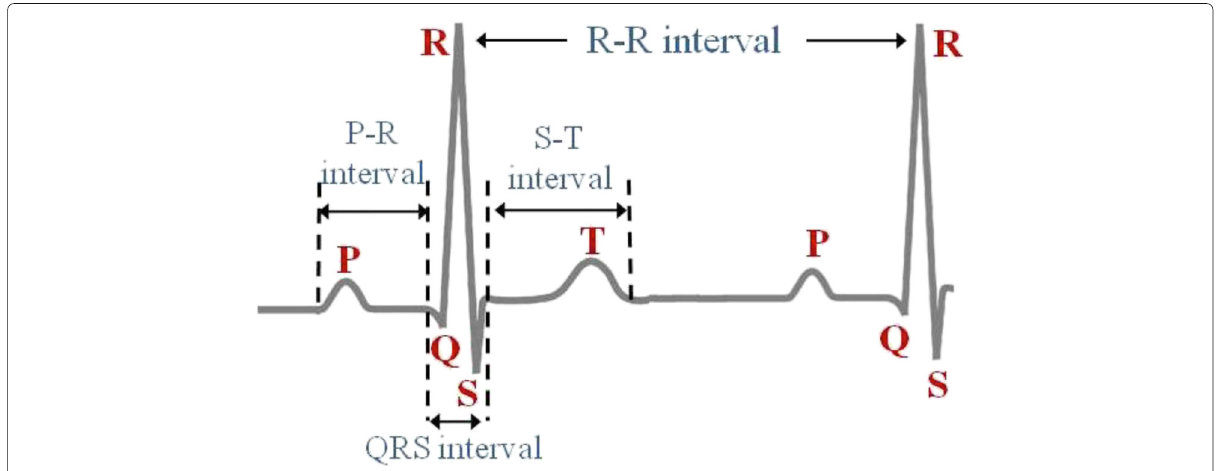
Fig. 2 P, Q, R, S, and T waves in a typical ECG